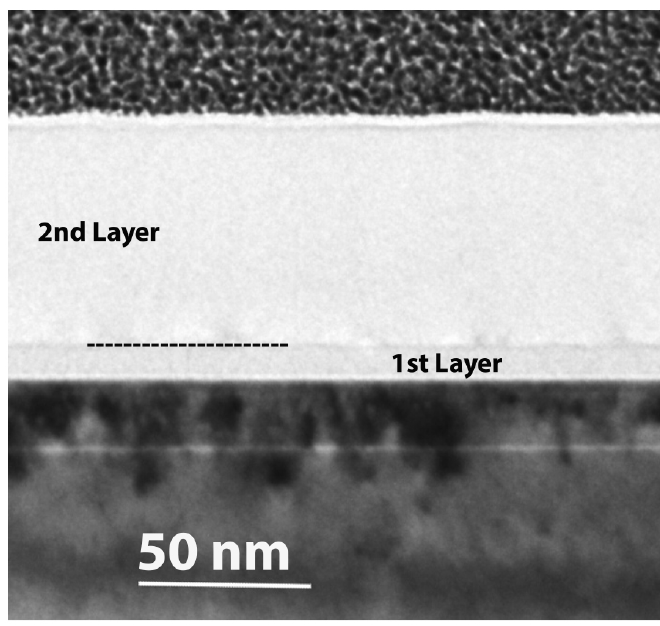
Figure 5. TEM cross-sectional image shows a distinguishable bilayer structure of the passivation layer. Reprinted with permission from Ref. [38]. Copyright 2018 by IEEE.